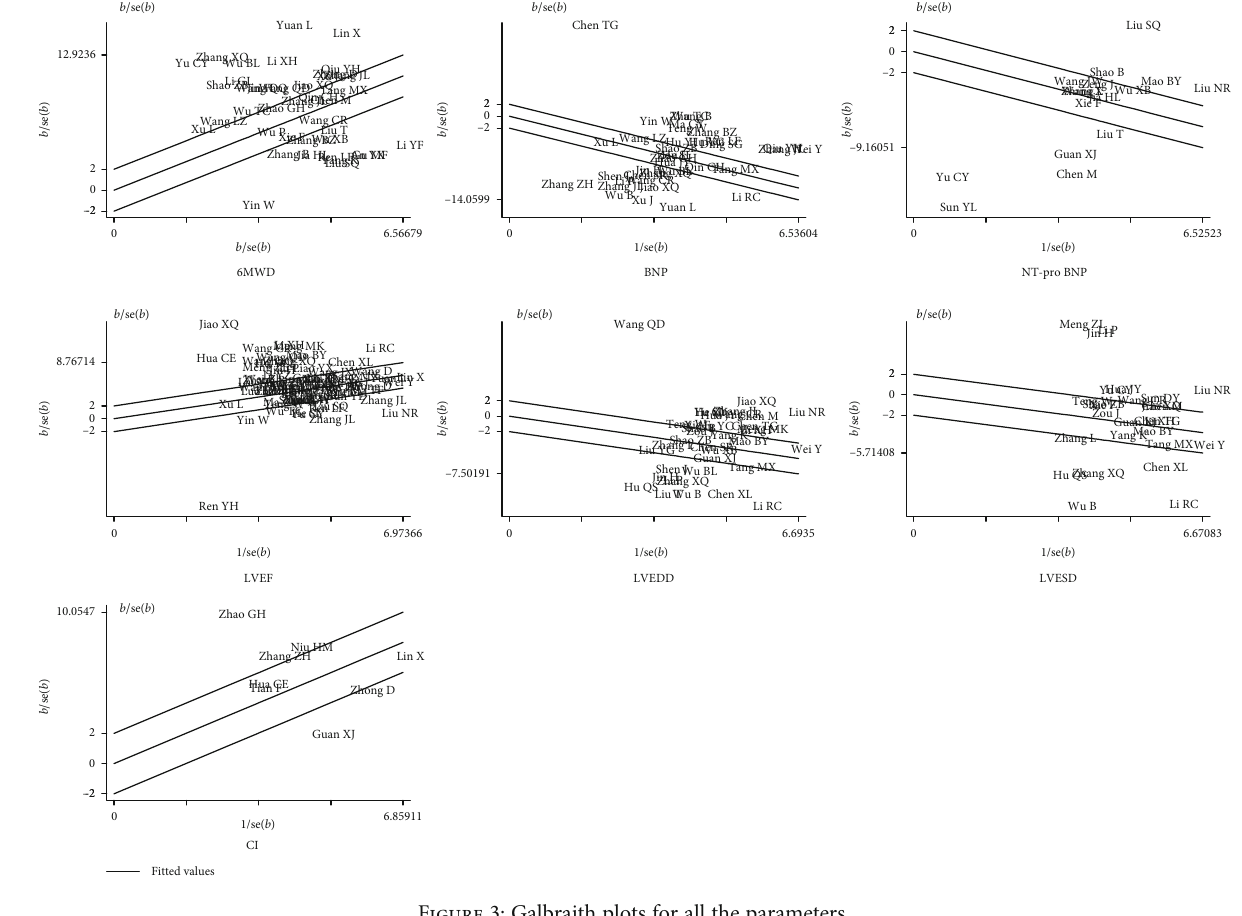
Figure 3: Galbraith plots for all the parameters.